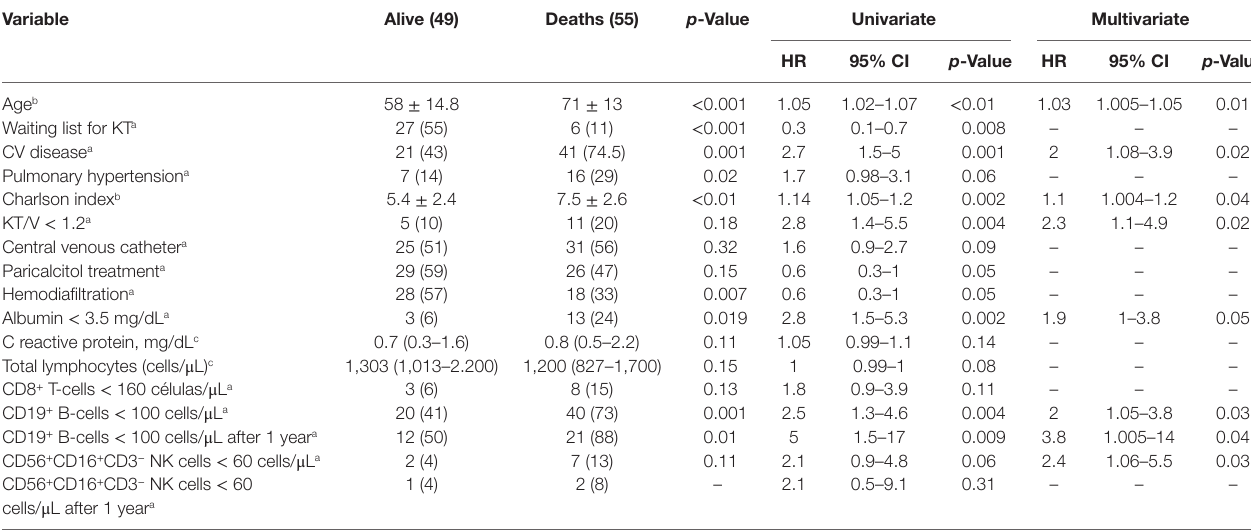
TaBle 4 | Univariate and multivariate analysis for all-cause